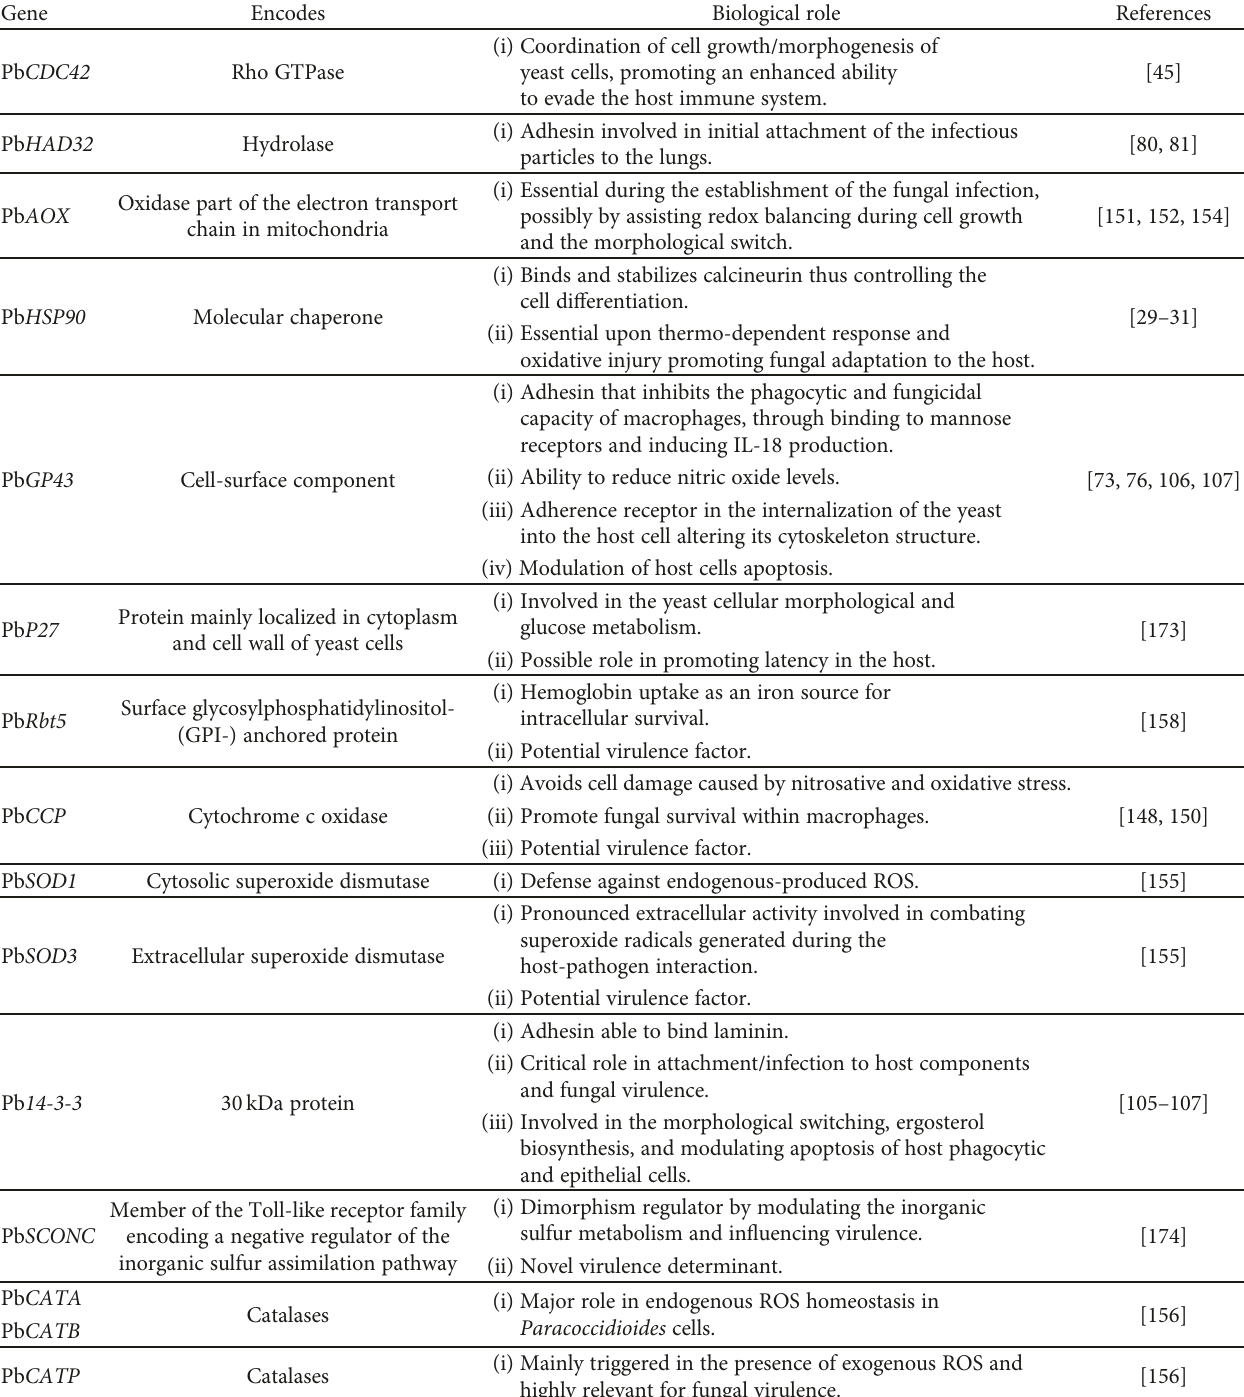
Table 4: Paracoccidioides spp. genes shown by functional molecular studies using antisense technology to be involved in virulence and/or immune-evasion strategies from the